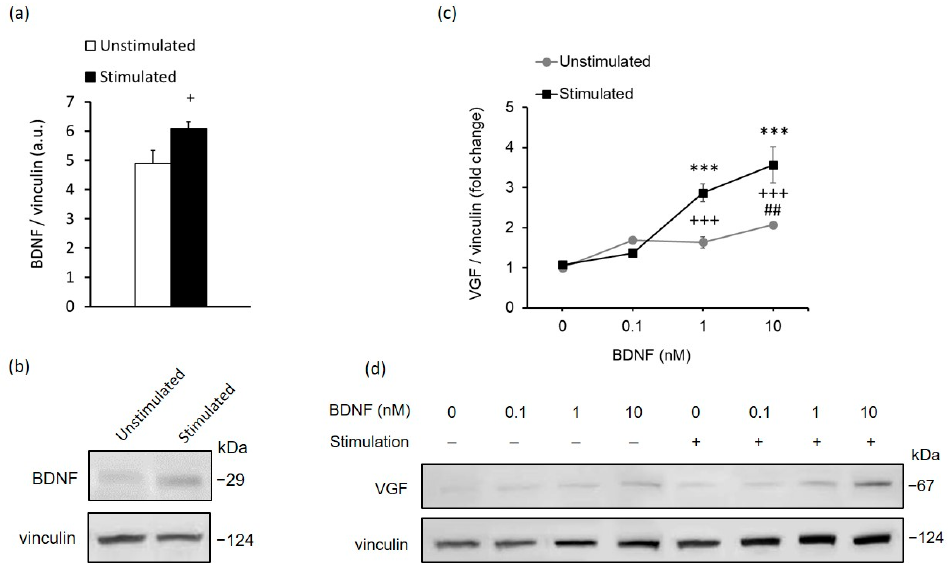
Figure 3. High-contrast stimulation of MCs potentiated their neurotrophic properties. ( a ) Densitometric Western blot analysis of BDNF expression in stimulated MCs with high contrast and unstimulated MCs; and ( b ) representative Western blot images from at least three independent experiments. Data are the means ± SEM. Difference between stimulated and unstimulated cells: + p < 0.05 (unpaired t -test). ( c ) Densitometric Western blot analysis of VGF expression in high-contrast-stimulated and unstimulated MCs, with additional exogenic BDNF administered at the indicated concentrations (0.1 nM, 1 nM, 10 nM), and ( d ) representative Western blot images of VGF from at least three independent experiments. The results are the means ± SEM. Data are presented as fold changes compared with VGF expression in the unstimulated MCs without BDNF treatment. Differences between the stimulated and unstimulated groups treated with the same concentration of BDNF: +++ p < 0.001. Differences between the high-contrast-stimulated group treated with BDNF and the high-contrast-stimulated group without BDNF treatment: *** p < 0.001. Differences between the unstimulated group treated with BDNF and the unstimulated group without BDNF treatment: ## p < 0.01 (two-way ANOVA followed by Tukey’s post-hoc test).